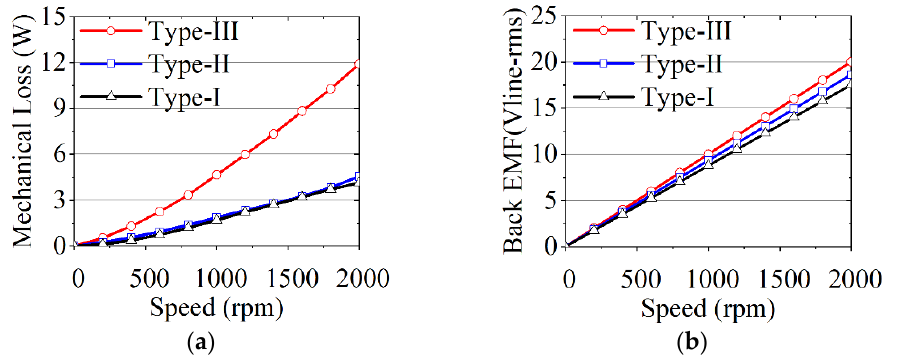
Figure 13. No-load test results: ( a ) Back-EMF, ( b ) Mechanical loss.